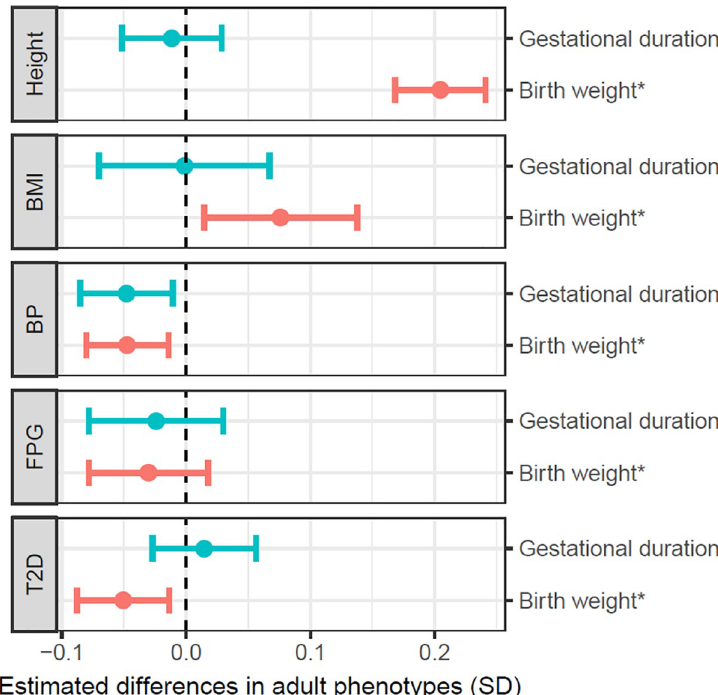
Fig 4. Estimated differences in adult phenotypes (in SDs) per 1-SD difference in birth weight and gestational duration. The birth weight was adjusted by gestational duration; 1 SD = 426 g. 1 SD of gestational duration was 11.4 days. The 1-SD values for adult phenotypes were assumed to be 6.4 cm (height), 4.0 kg/m 2 (BMI), 6.9 mmHg (BP), 0.37 mmol/L (FPG), and 1.81 for log OR of T2D. � indicates birth weight adjusted by gestational duration. BMI, body mass index; BP, blood pressure; FPG, fasting plasma glucose; SD, standard deviation; T2D, type 2 diabetes.